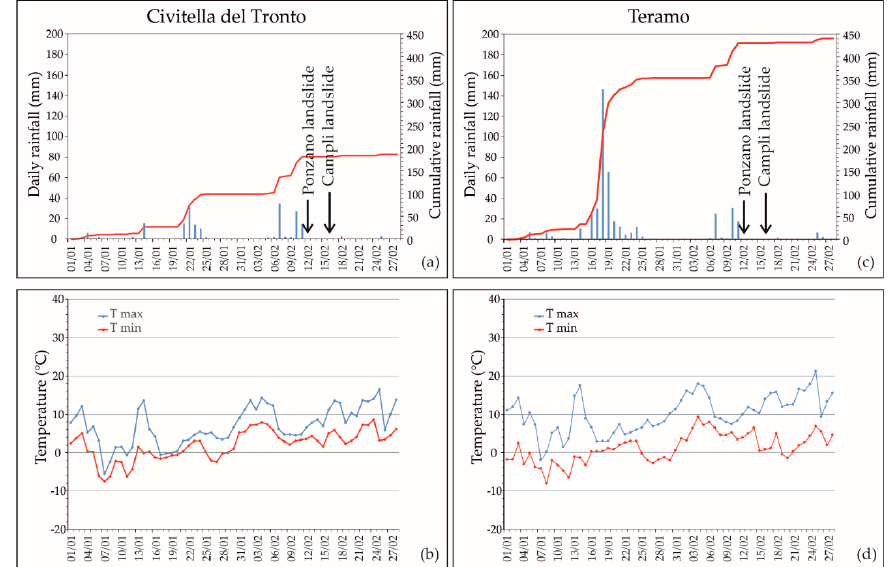
Figure 3. Daily rainfall–temperature diagrams for Civitella del Tronto ( a , b ) and Teramo ( c , d ) meteorological stations (location in Figure 2).